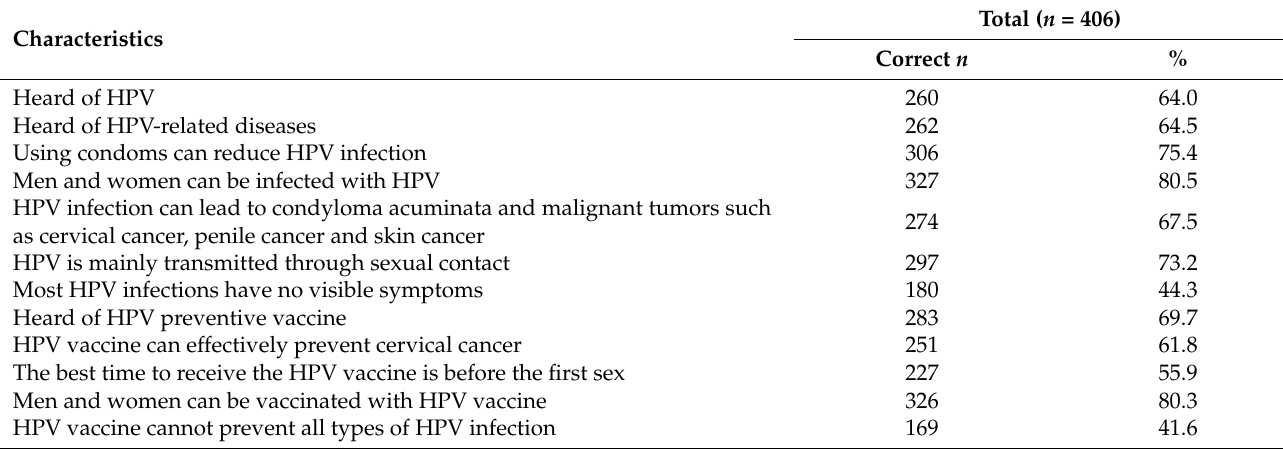
Table 4. HPV infection and vaccine-related knowledge responses in MSM survey population.